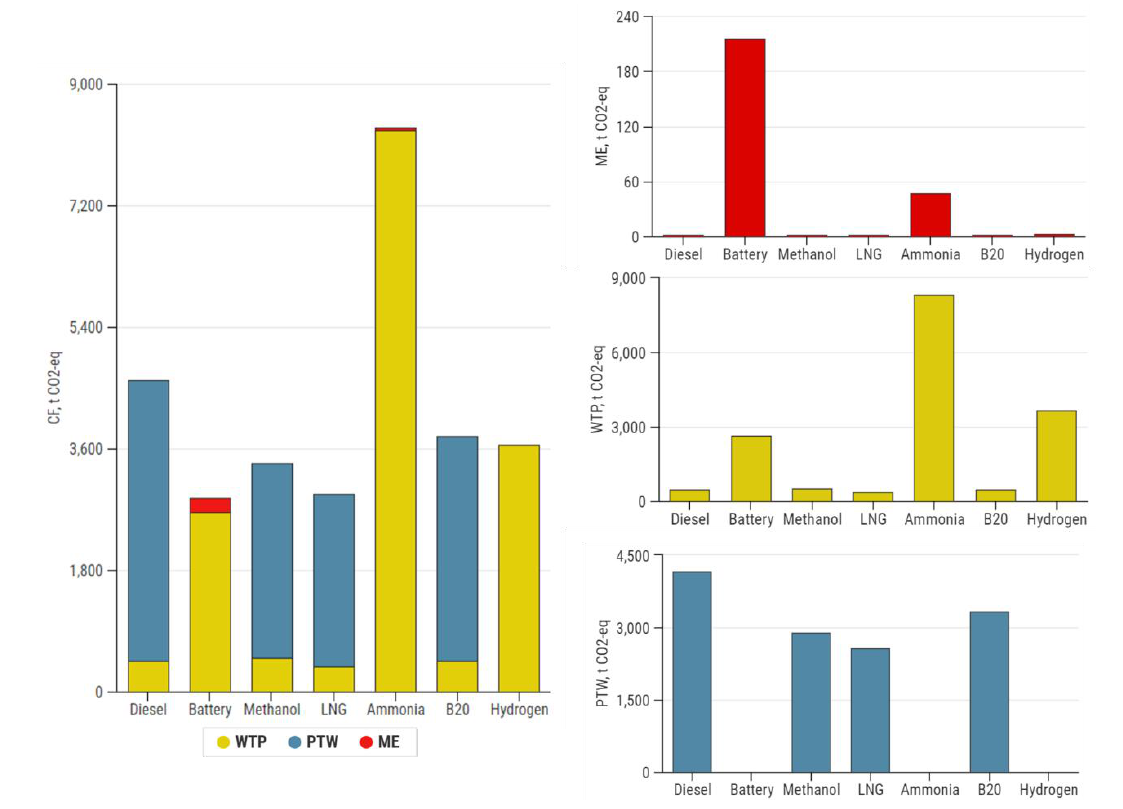
Figure 13. LCA results for a trawler “Jadran III”.